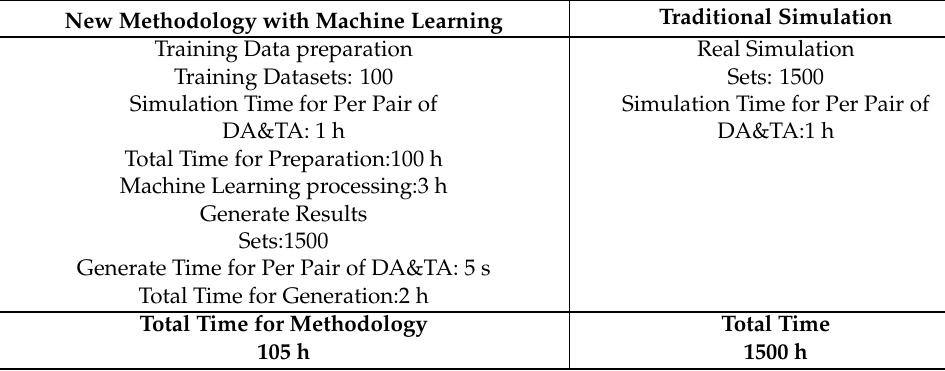
Table 3. Comparison of the efficiency of machine learning and